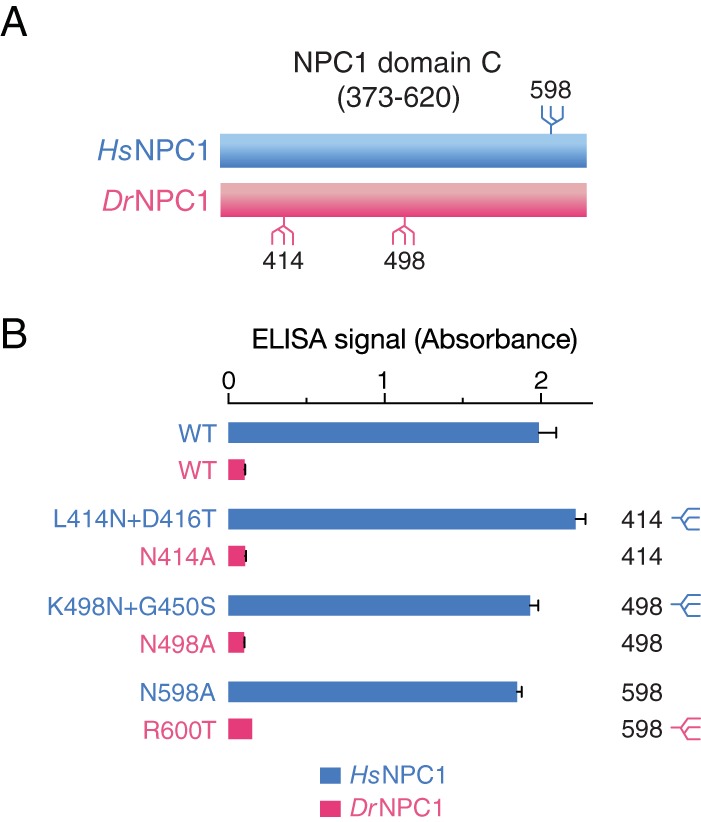
N-glycosylation of NPC1 domain C does not affect EBOV GPCL binding. (A) Location of the three unique sequons in HsNPC1 versus DrNPC1 domain C. (B) Glycosylation mutants were made in both HsNPC1 (losing sequon at position 598 and gaining sequons at position 414 and 498) and DrNPC1 (losing sequons at position 414 and 498 and gaining sequon at position 598). Domain C proteins were expressed in HEK 293T cells and tested for EBOV GPCL binding by ELISA.